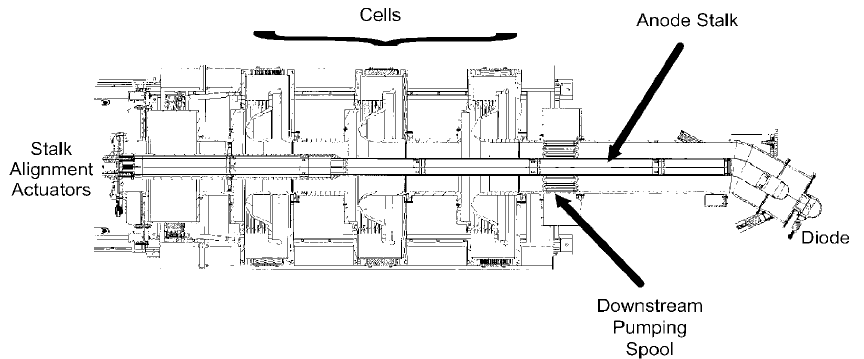
FIG. 37. Cygnus IVA cross